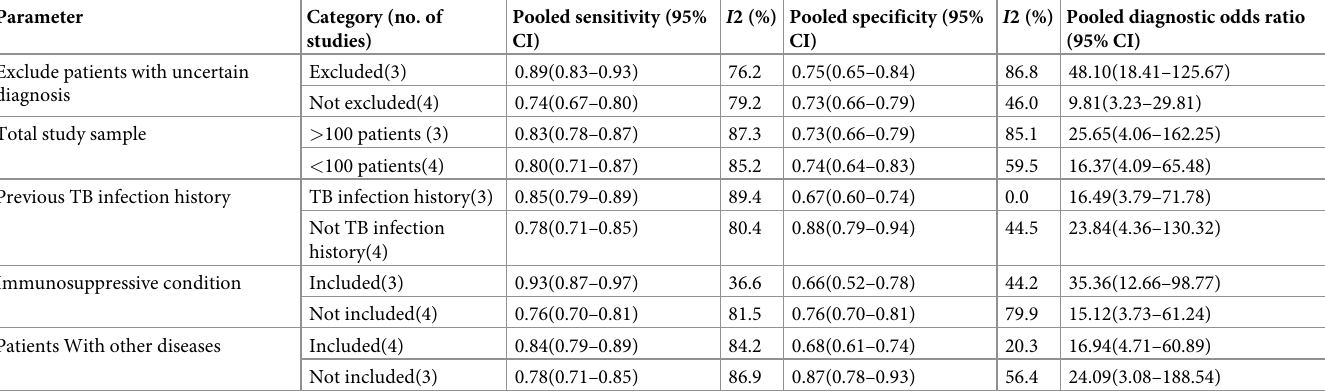
Table 2. Subgroup analysis for exploration of factors influencing heterogeneity.